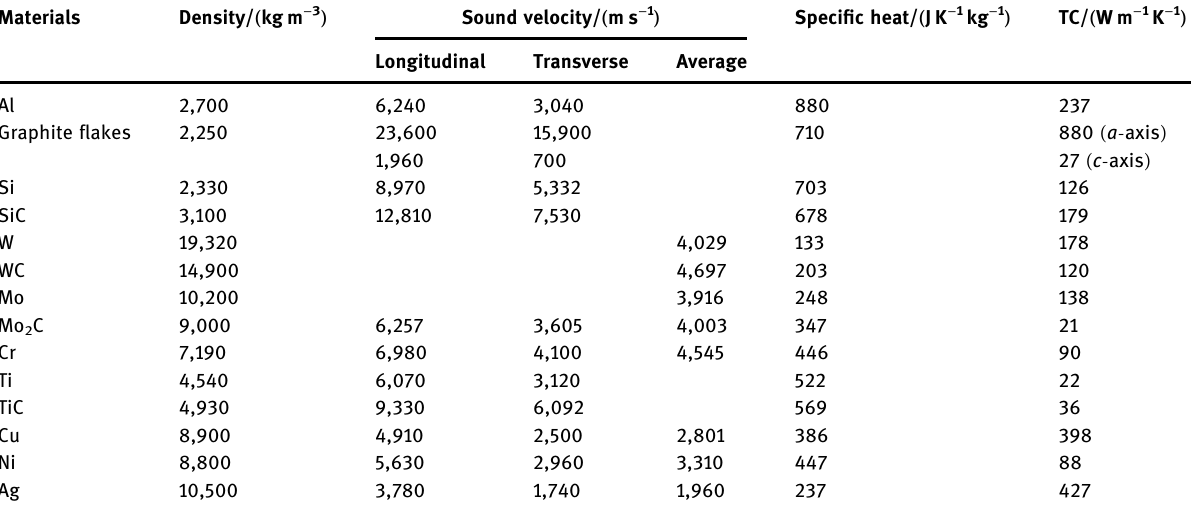
Table 1: Constants of coating materials [ 22,30 – 33 ]